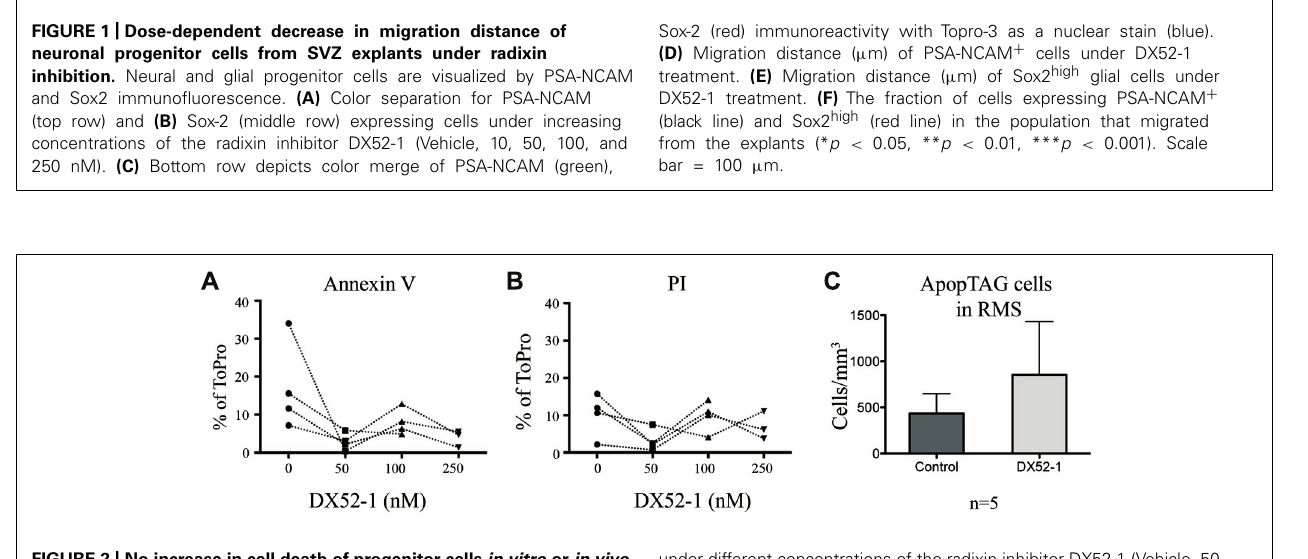
FIGURE 2 | No increase in cell death of progenitor cells in vitro or in vivo under radixin inhibition. Paired results from four different experiments showed no significant difference in thepercentage of cells that migrated out from SVZ explant cultures being AnnexinV postitive (A) or PI positive